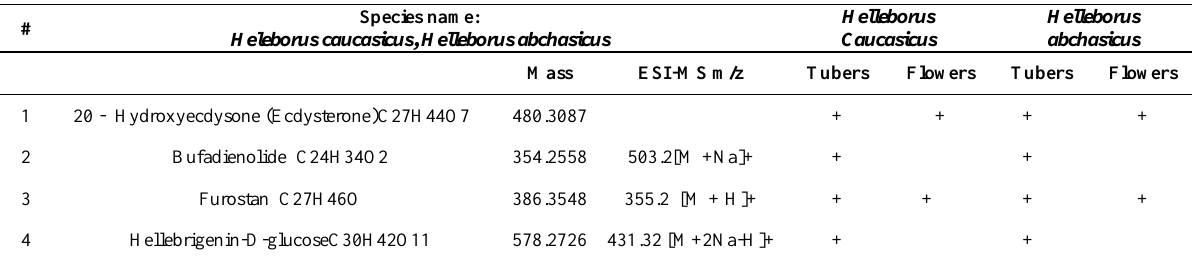
Table 2. Steroidal composition of Helleborus caucasicus, Helleborus